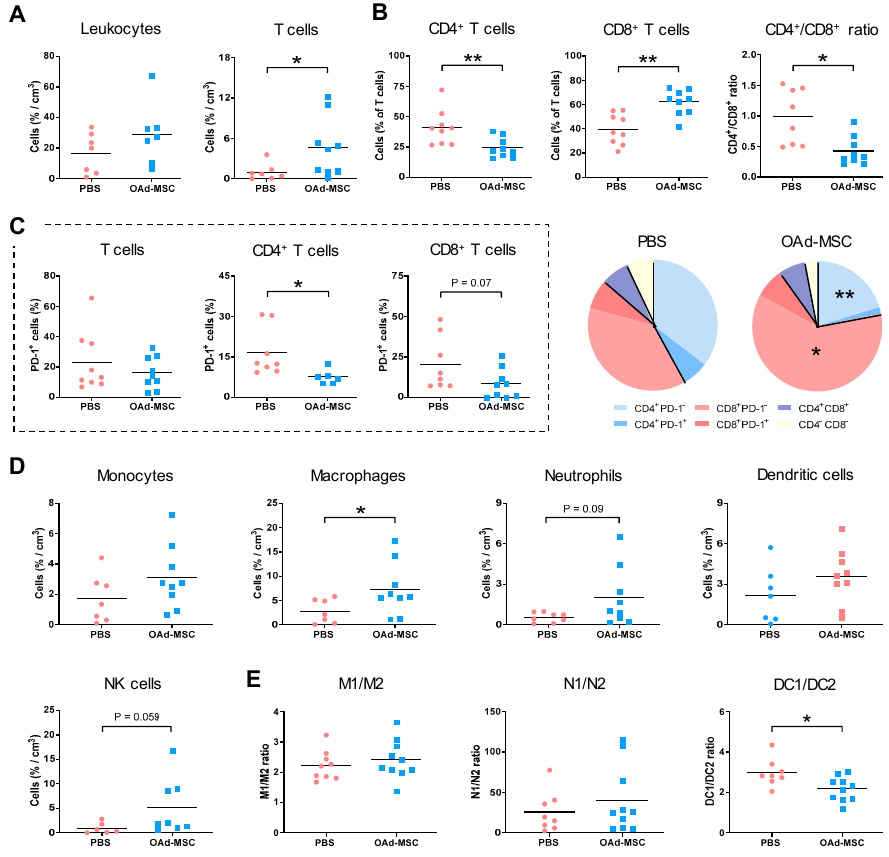
Figure 6. Tumor-infiltrating immune cells in melanoma. ( A ) Density of tumor-infiltrating lymphocytes (TILs) and leukocytes at the end point, expressed as percentage per cm 3 of tumor. ( B ) Percentage of CD4 + and CD8 + T cell subsets from T cells, as well as the CD4 + /CD8 + ratio. ( C ) Percentage of TILs, CD4 + , and CD8 + T cells expressing PD-1. Pie chart shows percentages of CD4 + PD-1 − (blue), CD4 + PD-1 + (dark blue), CD8 + PD-1 − (red), CD8 + PD-1 + (dark red), CD4 + CD8 + (purple), and CD4 − CD8 − (yellow) T cell subsets from TILs. ( D ) Density of tumor-infiltrating innate immune cells and NK cells; ( E ) Ratio of pro-inflammatory (1) and anti-inflammatory (2) status of macrophages, neutrophils, and dendritic cells ( n = 7–9). (Mann-Whitney U test): * p < 0.05, ** p < 0.01.